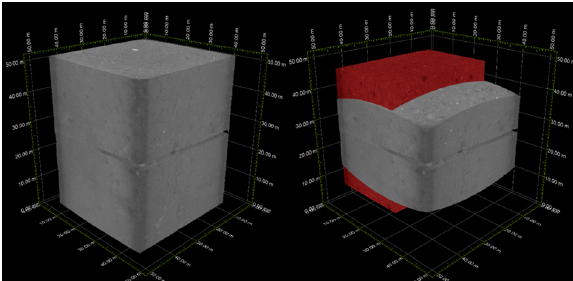
Figure 3. Visualization of the obtained 3D model of the scanned area. Part indicated by the red color specifies the volume used for the determination of porosimetric parameters and further investigation of the crack spatial